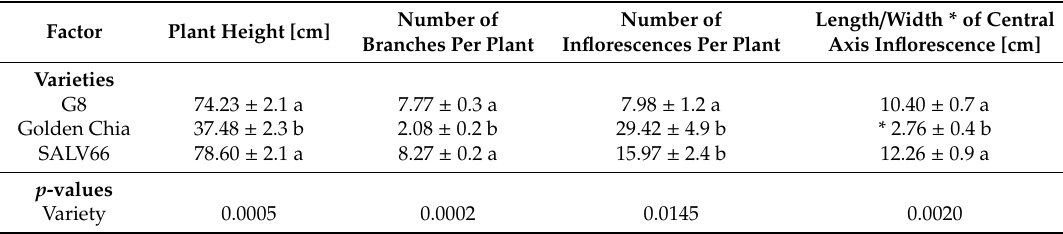
Table 4. Mean plant height, number of branches, number of inflorescences per plant and length / width of central axis inflorescence per single plant of three chia varieties (G8, Golden Chia, SALV66) cultivated